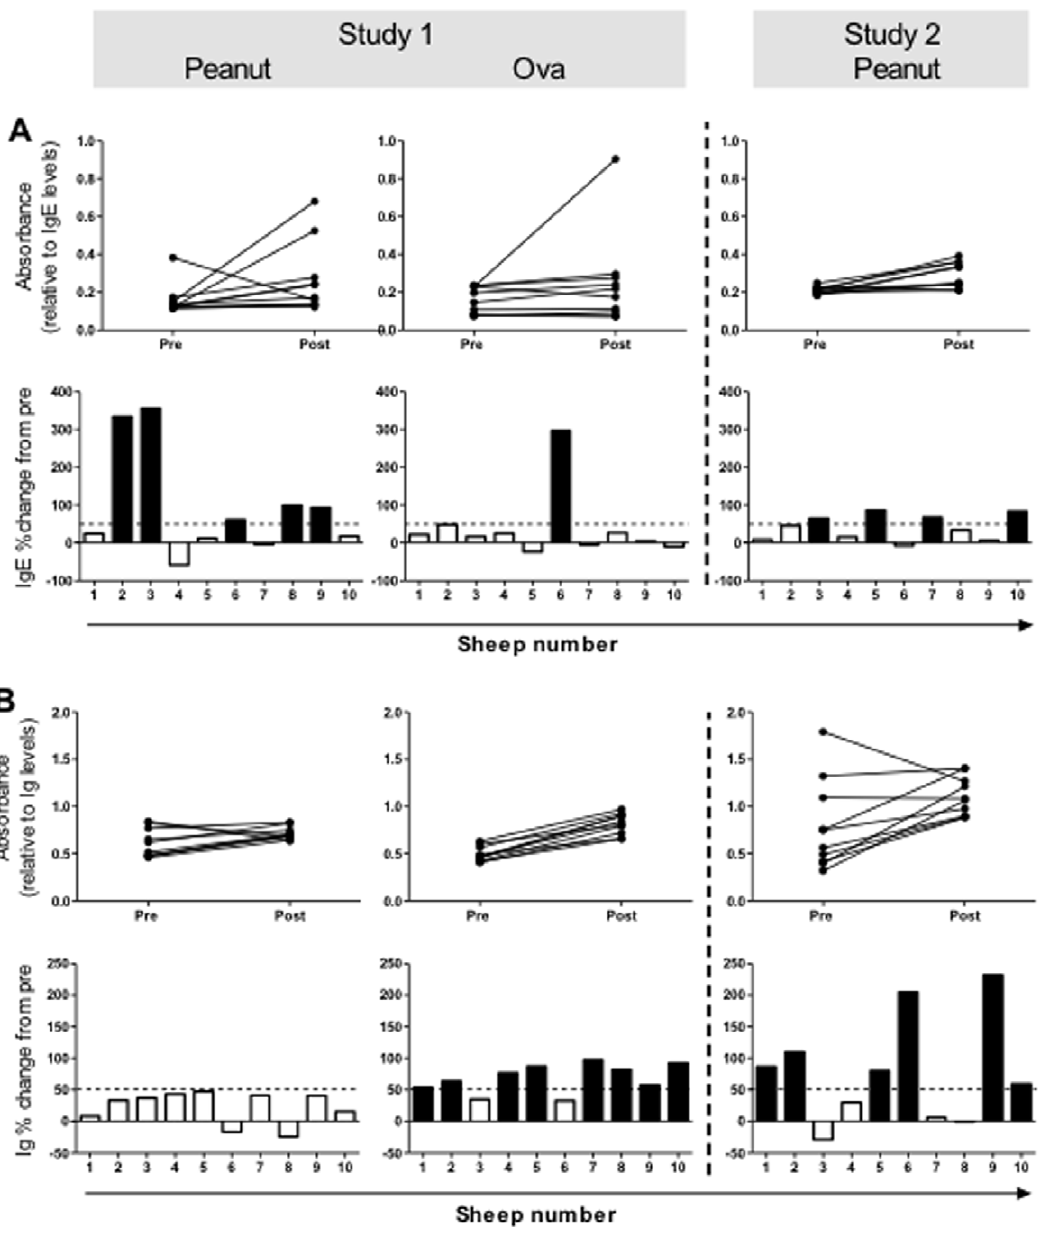
Figure 1. Serum Ig responses to peanut (PN) and ovalbumin (OVA) immunisations. Peripheral blood serum samples were collected at baseline (pre) and 7 days after the final PN/OVA immunisation (post). Line graphs depict allergen-specific IgE (A) and total Ig (B) levels (absorbance read at 450 nm) for individual sheep. Percentage change from baseline for each animal is presented in the bar graphs for allergen-specific IgE (A) and total Ig (B) levels. Solid bars illustrate a percentage change greater than